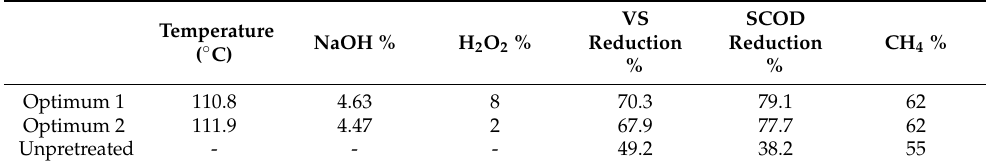
Table 6. Optimum biomethane production conditions in the scenarios.